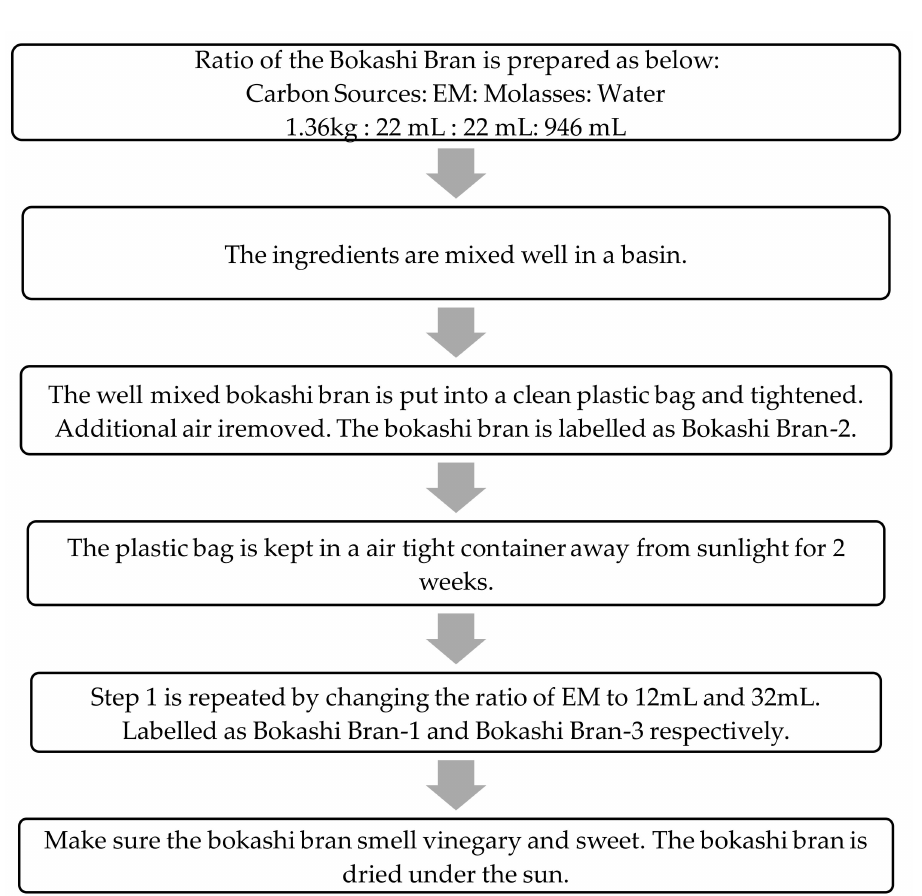
Figure 5. The process flow of the preparation of bokashi brans. Three types of bokashi bran were produced using a similar medium but different formulation, as shown in Table 2. The amount of the EM-1 and molasses was fixed at 1 to 1 ratio in order to ensure no effects of molasses on the bokashi formulation. The usage of molasses only was to enhance the growth of microorganism during the bokashi-composting process. With this formulation, the relationship between EM-1 volumes with the carbon source (wheat bran) will be determined and